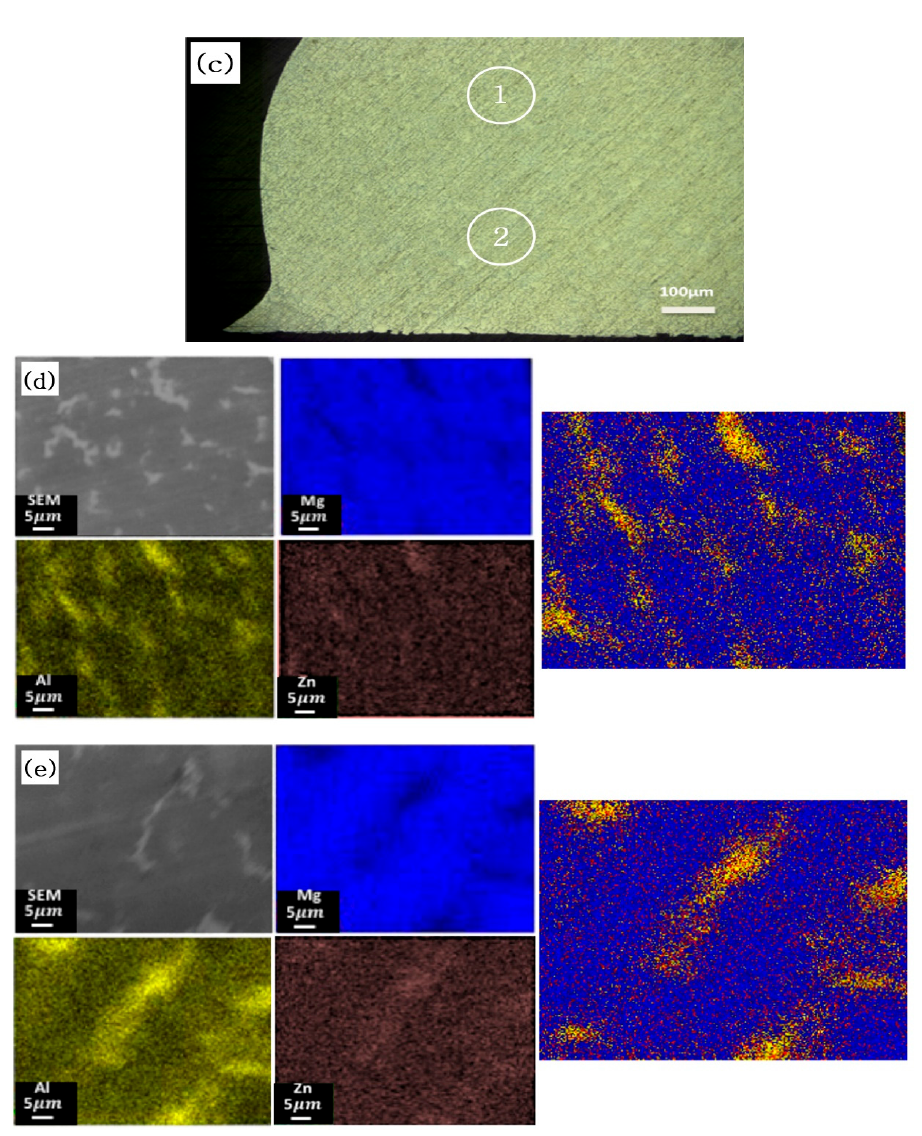
Figure 6. ( a ) XRD spectra of as-received wire, representative peaks of magnesium (a phase), zinc, and Mg 18 Al 13 precipitates (b phase); ( b ) XRD spectra of a representative printed line, representative peaks of pure magnesium (a phase) and Al 5 Mg 11 Zn 4 precipitates (j phase); ( c ) representing the areas from which the elemental mappings were taken; ( d ) Elemental Mapping of zone 1 [24]. Copyright